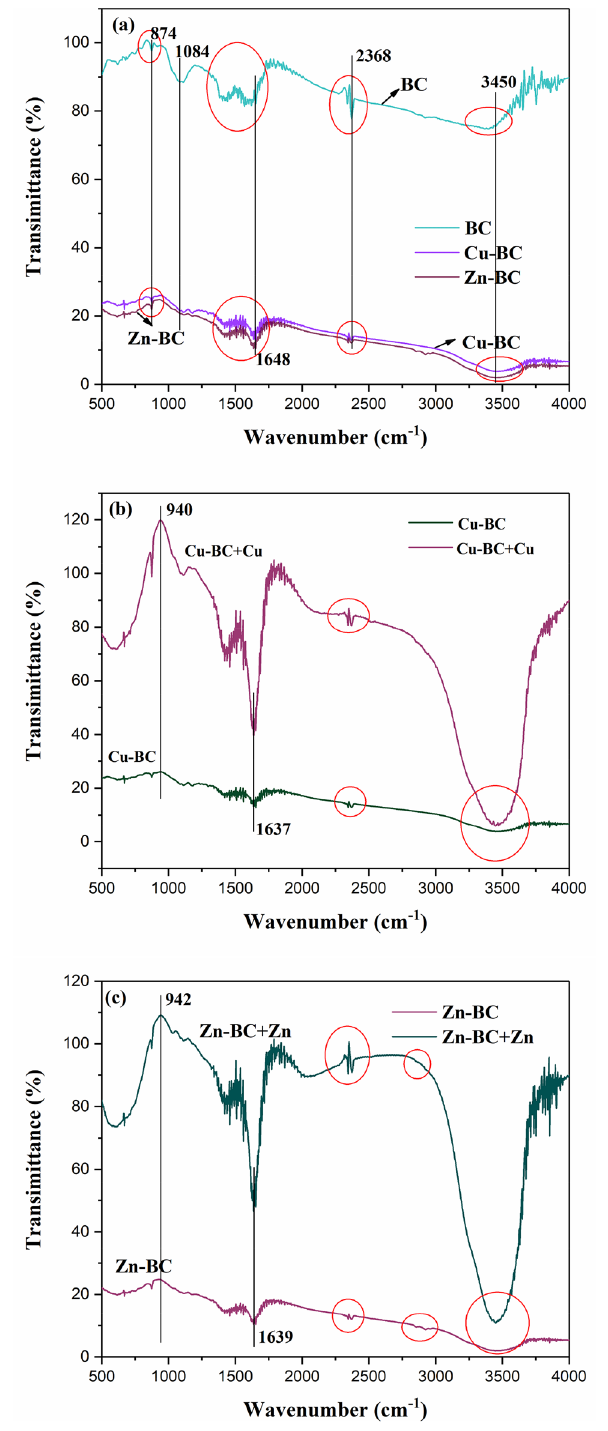
Figure 11. FTIR spectra of ( a ) BC, Cu-BC and Zn-BC; ( b ) Cu-BC and Cu-BC + Cu; ( c ) Zn-BC and Zn-BC +